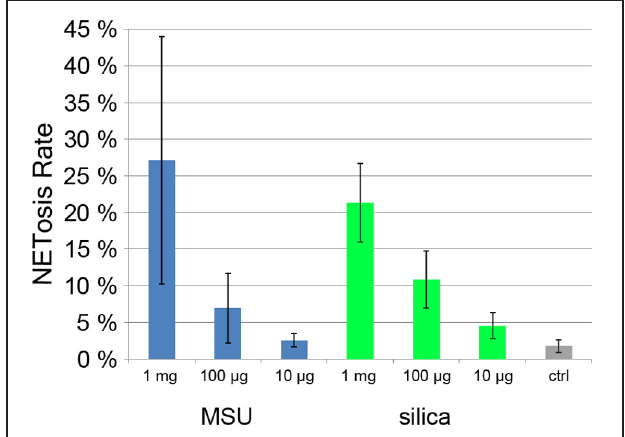
FIGURE 6 | Quantification of NET induction by monosodium urate (MSU) and silica